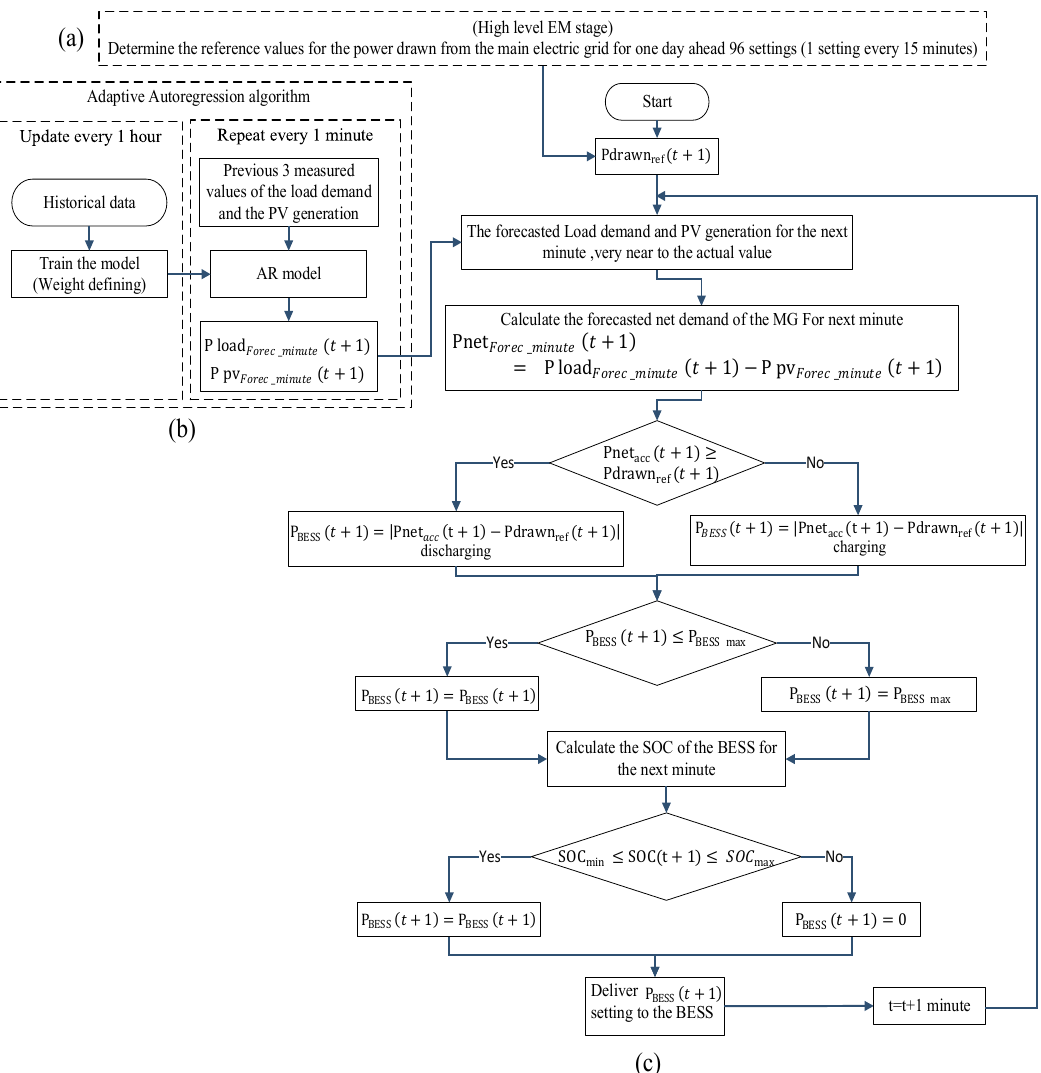
Figure 6. ( a ) High level EM stage; ( b ) adaptive autoregression forecasting algorithm; ( c ) operating procedure for the RTPC.